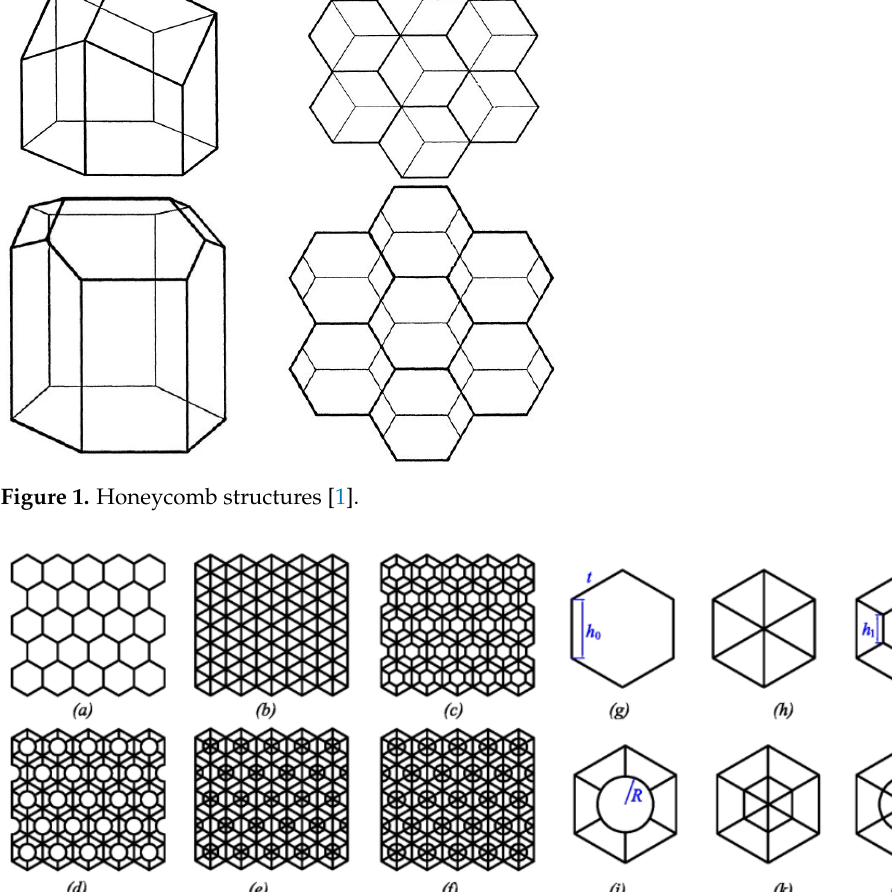
Figure 2. Honeycomb structures of cell interiors. ( a ) general structure; ( b ) triangular; ( c ) double hexagonal; ( d ) inside circular; ( e ) full double hexagonal; ( f ) full inside circular; ( g ) cell of hexagonal; ( h ) cell of full-triangular; ( i ) cell of double hexagonal; ( j ) cell of inside circular; ( k ) cell of full inside hexagonal; ( l ) cell of full inside circular [9].